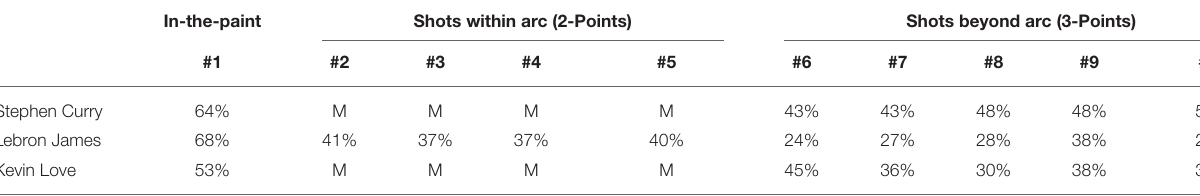
TABLE 3 | Shooting charts of curry, james and love for the 2015–2016 NBA season. In-the-paint Shots within arc (2-Points) Shots beyond arc (3-Points) #1 #2 #3